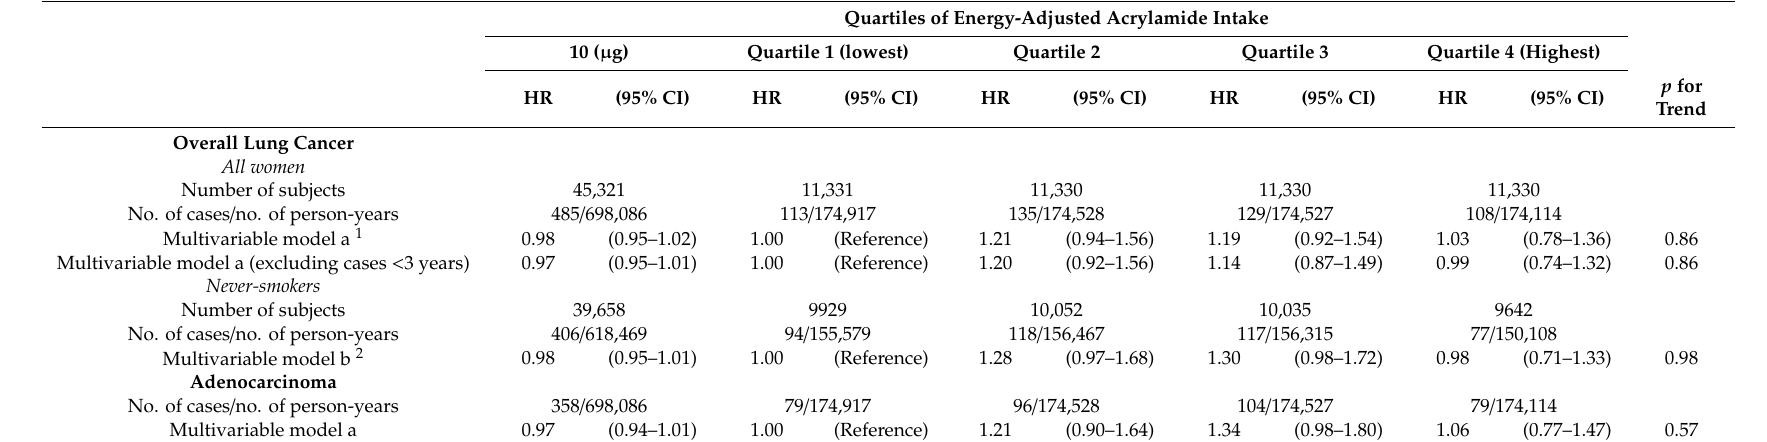
Table 3. Hazard ratios (95% confidence intervals) for lung cancer in women according to quartiles of acrylamide